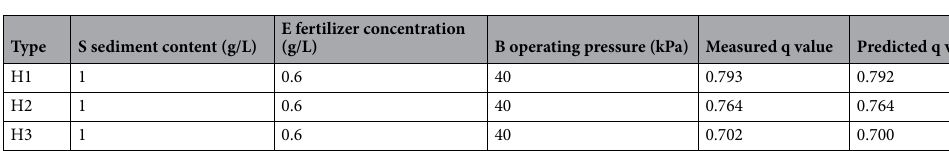
Table 8. Optimal combination of average relative